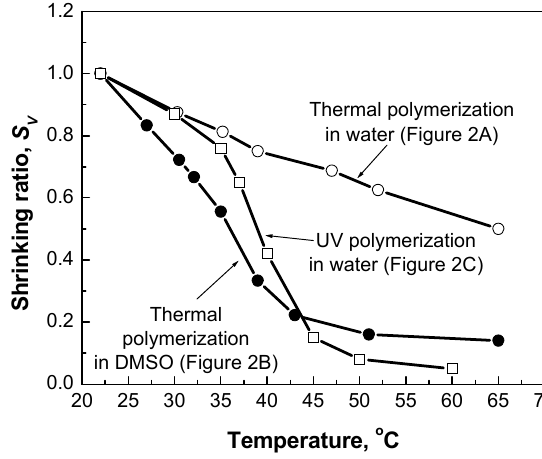
Figure 3. Shrinking abilities S V of the bulk PNIPA-FA hydrogels prepared by thermal and UV polymerization in different solvents.